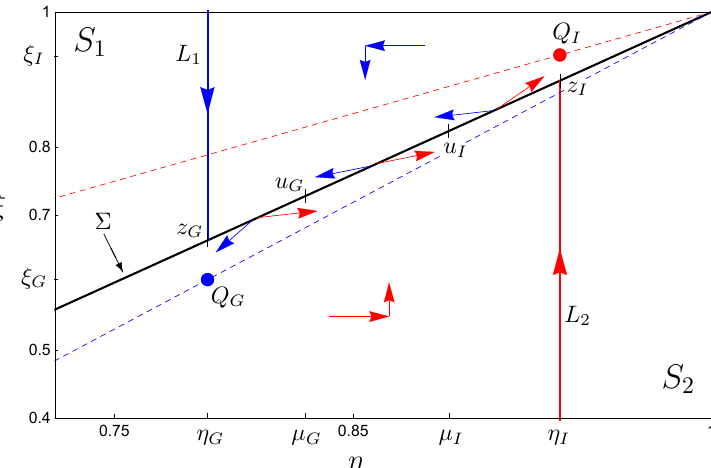
Figure 6. The Filippov flow set-up. Above Σ and to the right of L 1 , φ G -trajectories move left and downward (blue arrows). Below Σ and to the left of L 2 , φ I -trajectories move right and upward (red arrows). The blue and red dashed lines are the ξ -nullcines for systems (20) and (21), respectively. Vector fields V G (blue) and V I (red) are schematically indicated on Σ . We refer the reader to the text for further